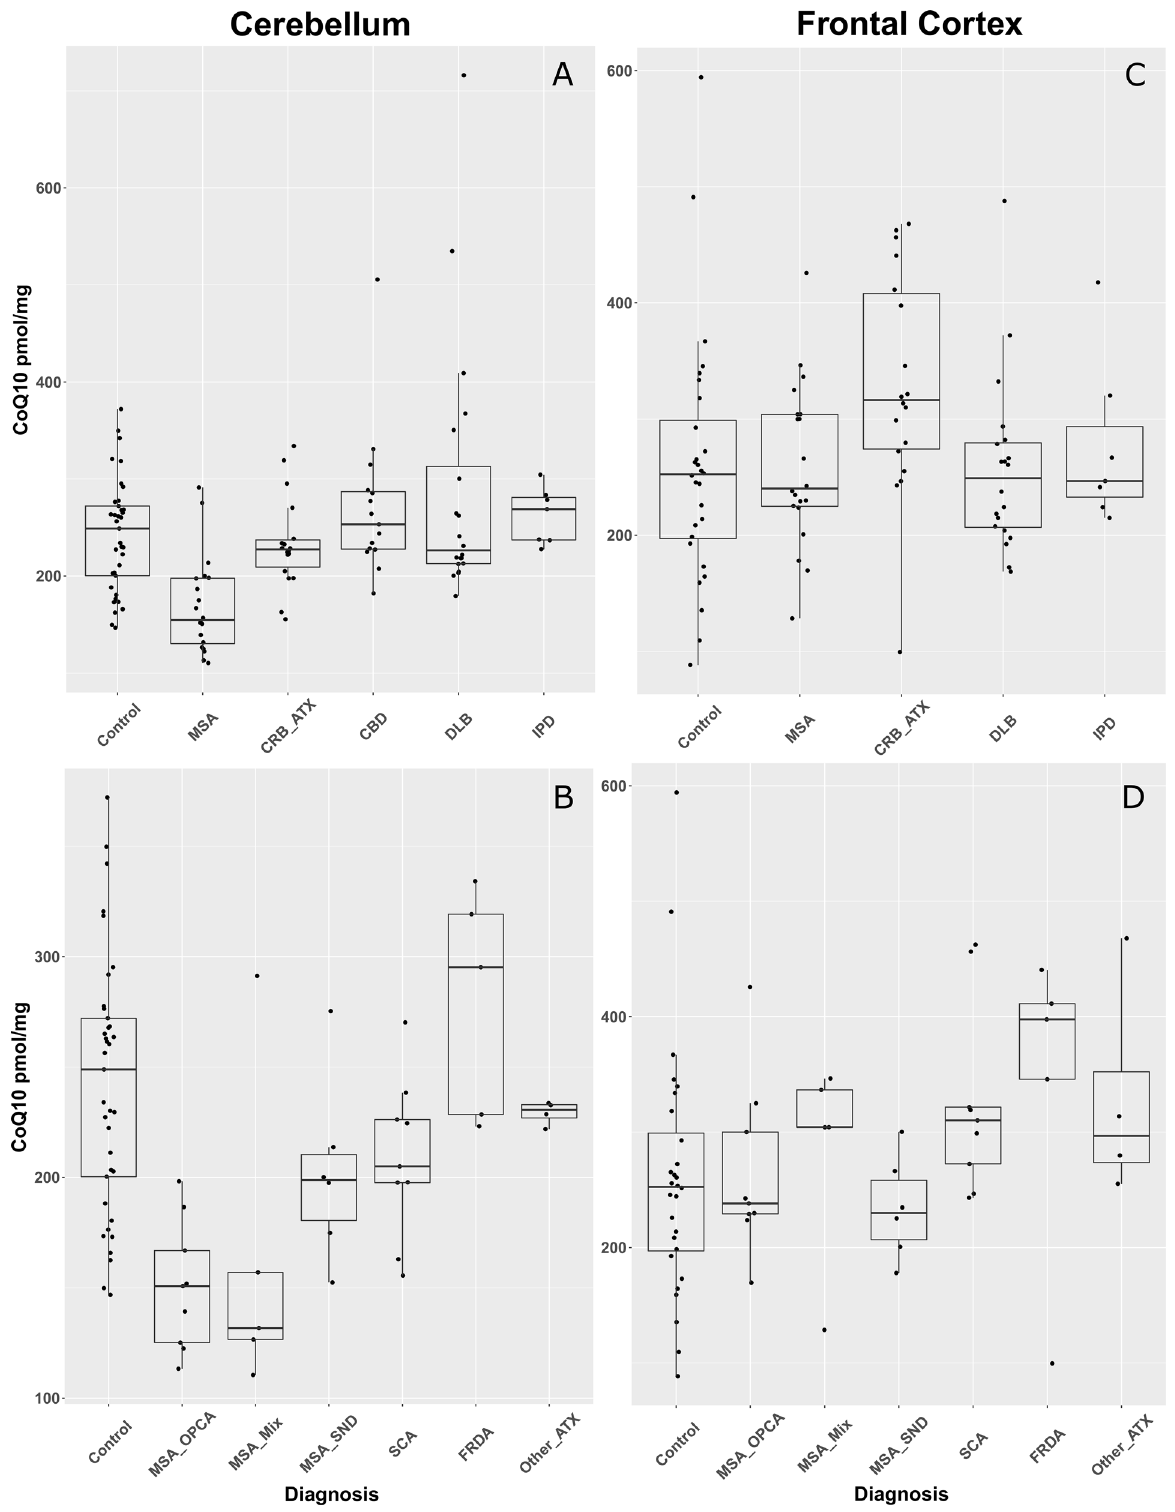
Fig 1. A: Boxplot presenting CoQ10 levels in the cerebellum of MSA, CBD, DLB, IPD, CRB_ATX and controls. B: Boxplot presenting CoQ10 levels in the cerebellum of MSA cases subdivided by pathological subtypes MSA_SND, MSA_mixed and MSA_OPCA, and also CRB_ATX cases subdivided into SCA, FRDA and other_ATX. C: Boxplot presenting CoQ10 levels in the frontal cortex of MSA, DLB, IPD, CRB_ATX and controls. D: Boxplot presenting CoQ10